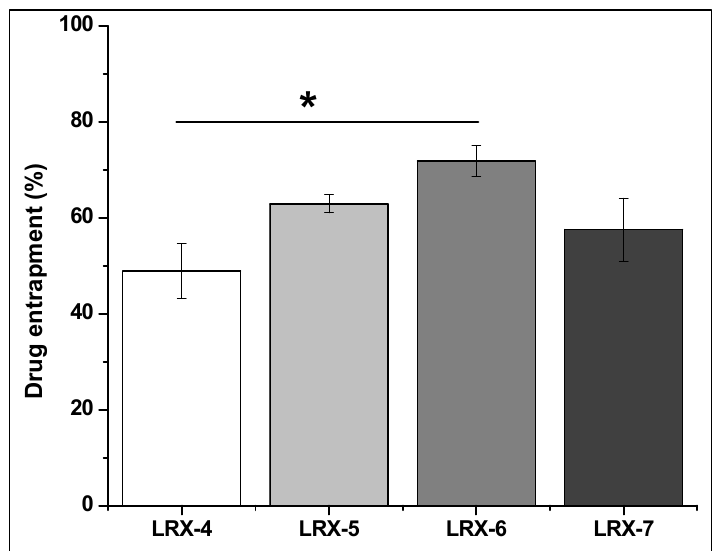
Figure 5. Drug entrapment efficiency of selected LRX formulations (one-way ANOVA, p < 0.05) LRX-6 vs LRX-4.